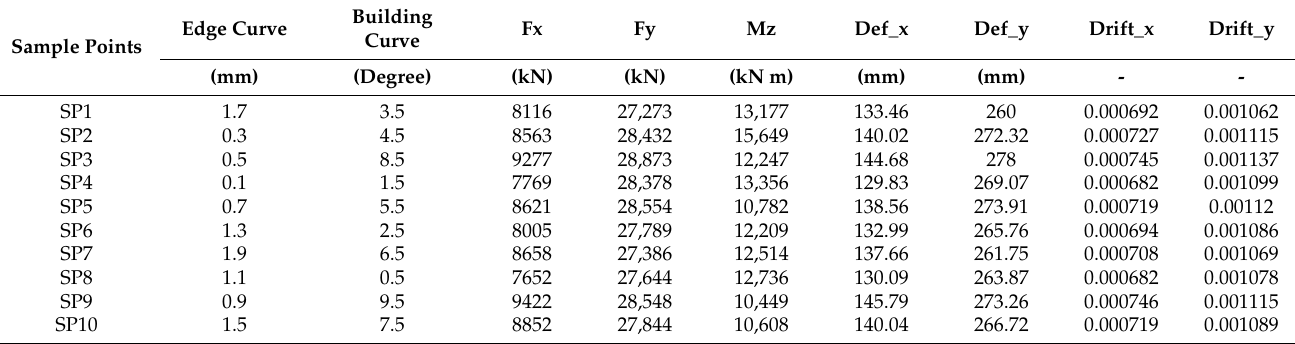
Figure 17. Maximum inter-story drifts. Table 3. Sampling points evaluation summary.